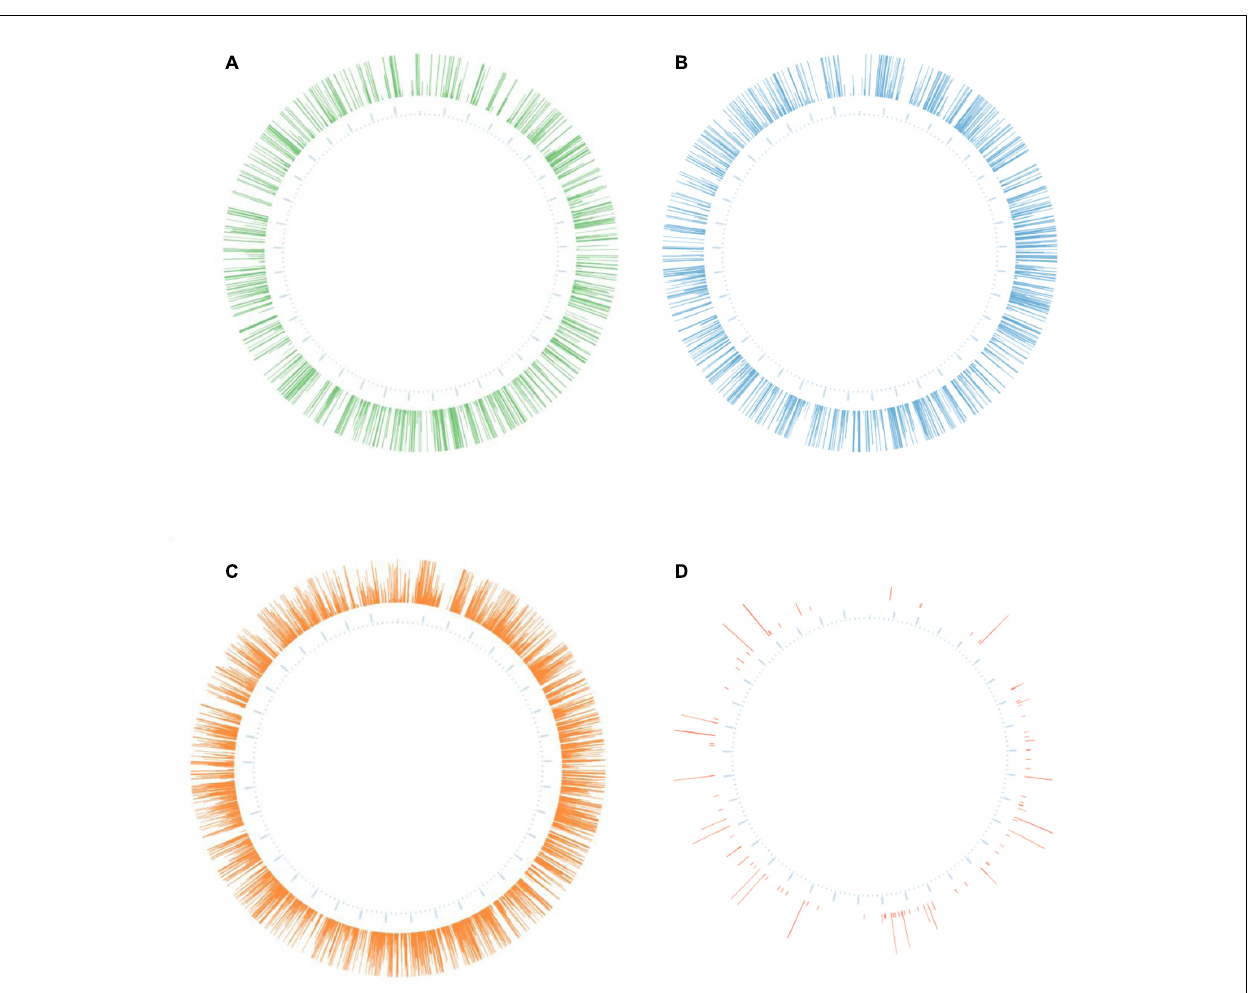
Frontiers in Microbiology |